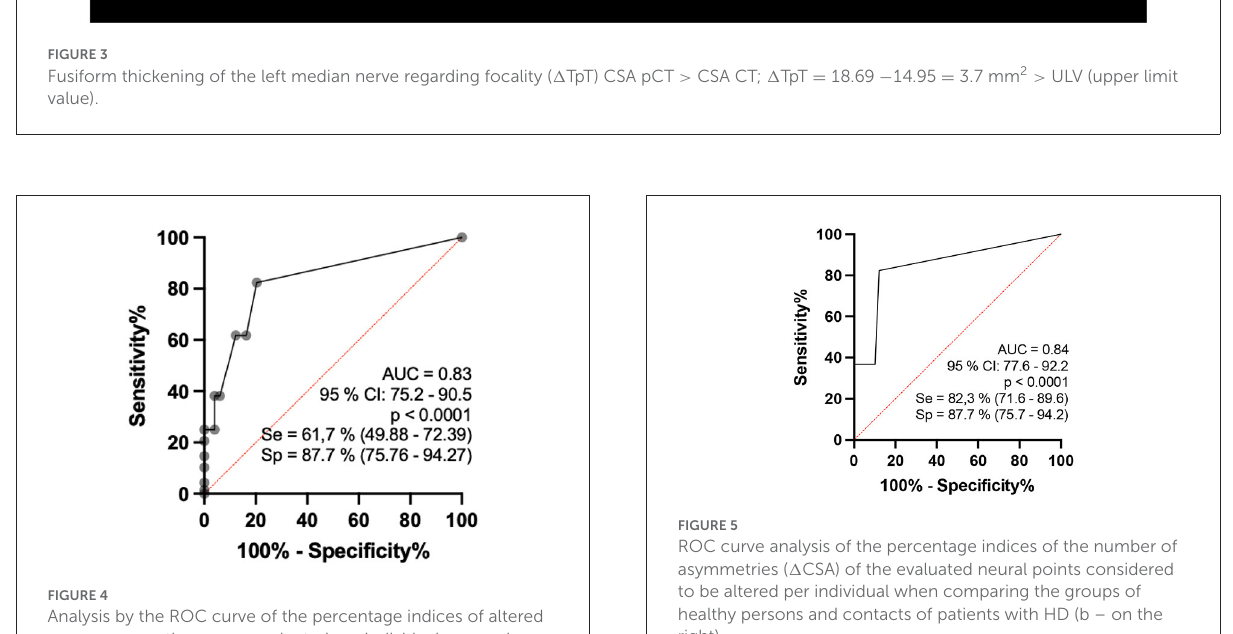
points of the same nerve ( 1 TpT) defined as altered (greater